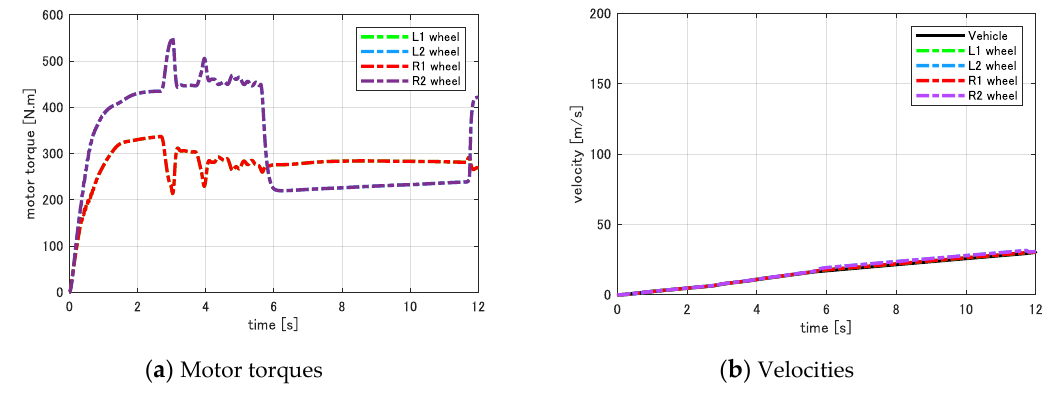
Figure 16. Simulation results of Case 2: with passivity-based anti-slip control.